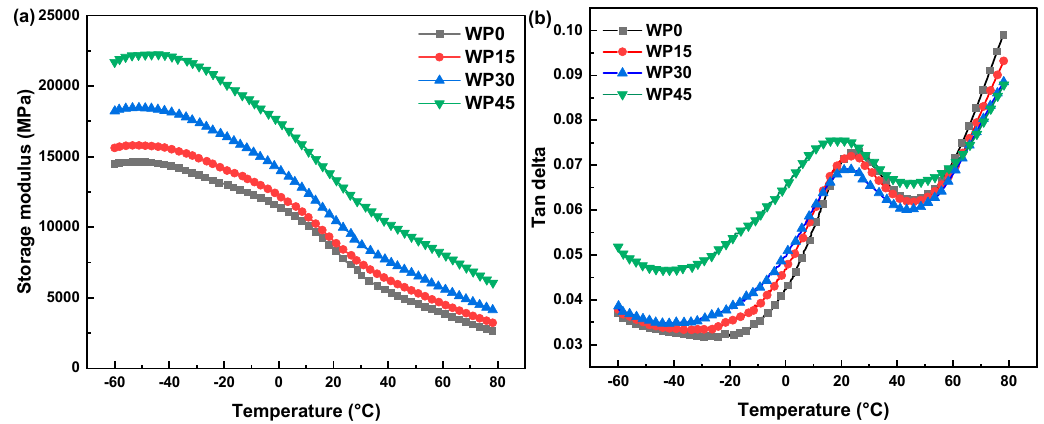
Figure 6. Dynamic mechanical analysis (DMA) test curves of the samples immersed in distilled water ◦ C: ( a ) storage modulus and ( b ) tan at a temperature of 60 °C: ( a ) storage modulus and ( b ) tan delta. at a temperature of 60